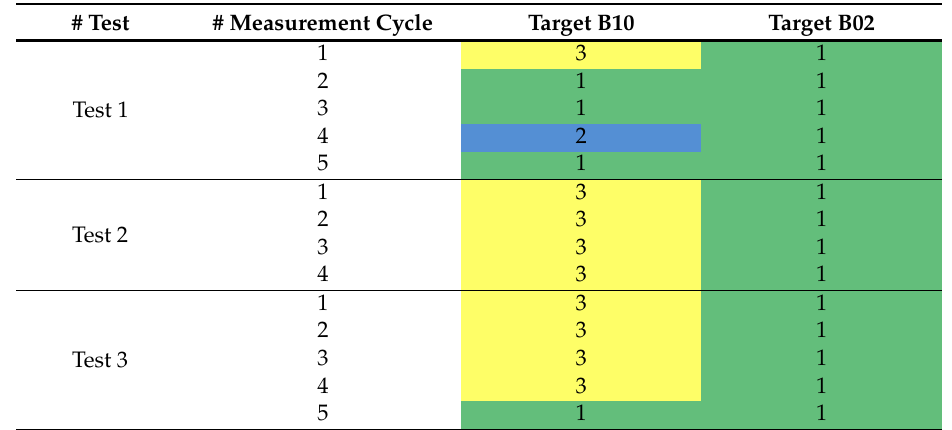
Table 10. Results of the three tests performed at FOI for target